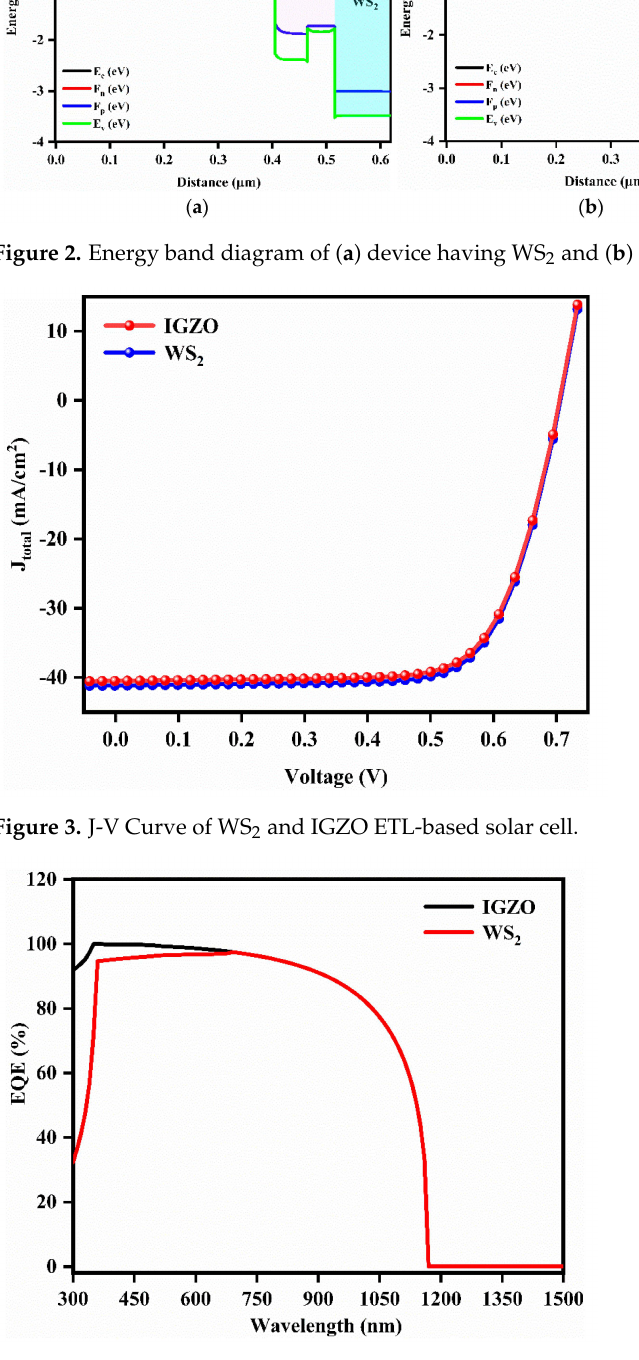
Figure 4. External Quantum Efficiency of WS2 ETL- and IGZO ETL-based solar